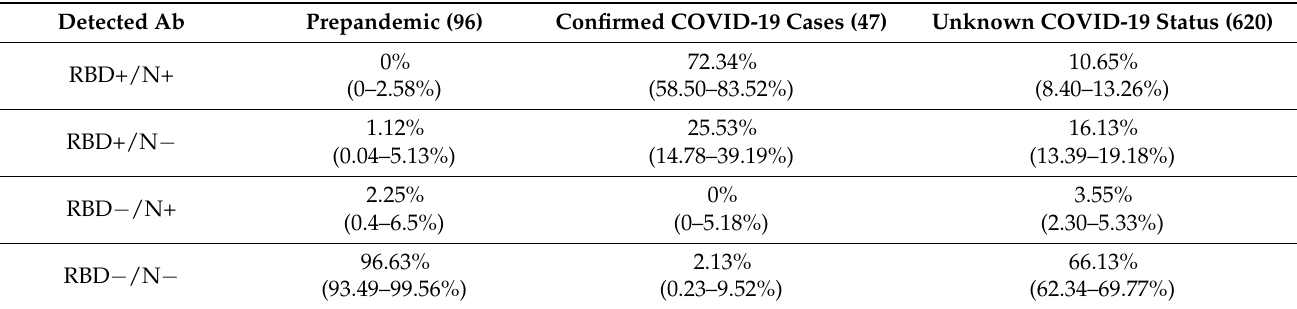
Table 1. Distribution of RBD-positive and N-positive signals in different sets of samples: negative controls, confirmed COVID-19 cases, and general public cohort. The total number of samples tested in each category is shown in the ta- ble heading. The percentage of positive samples for each serotype is presented with 95% confidence interval shown in parentheses.